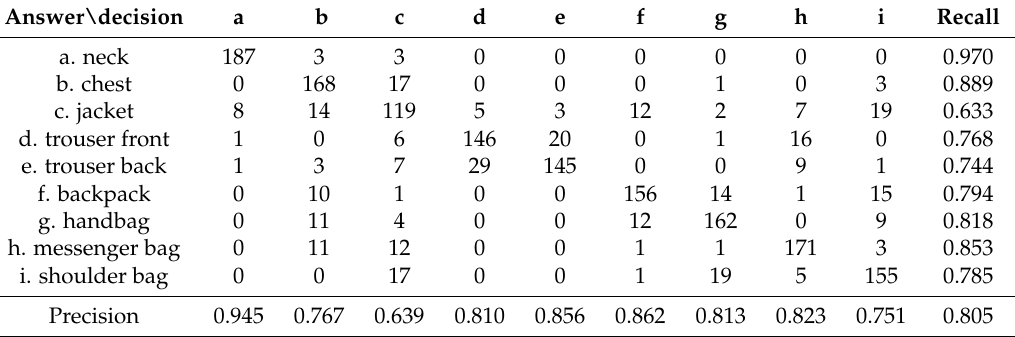
Table 10. Confusion matrix of LOSO-CV for the 9-class classification (averaged per person). Answer\decision